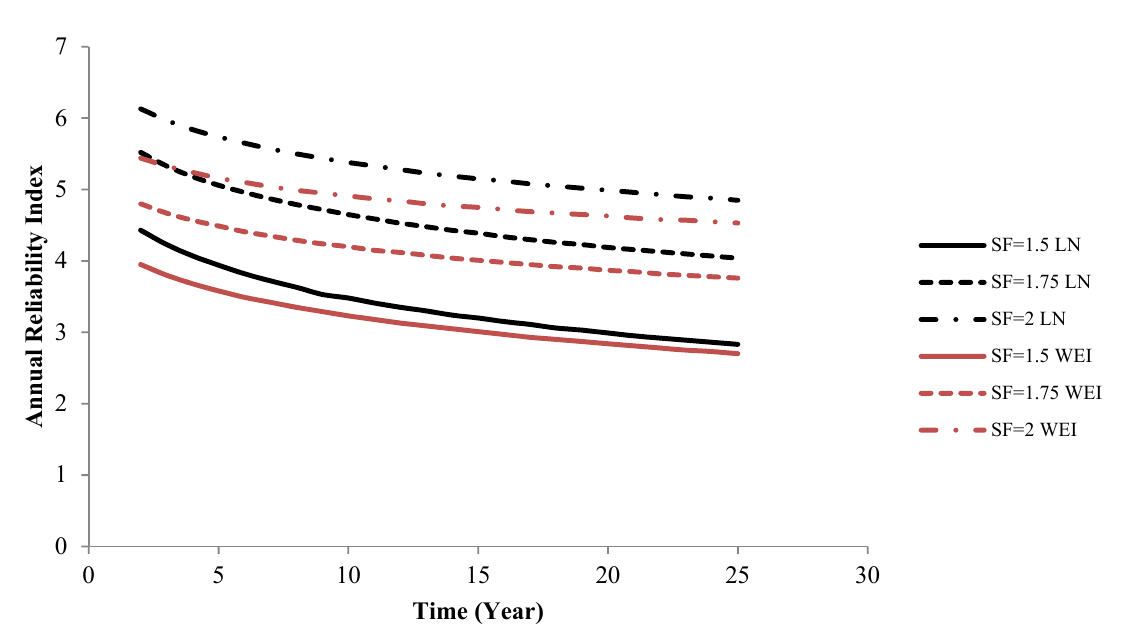
 = 1.5, 1.75 and 2.0 using the m